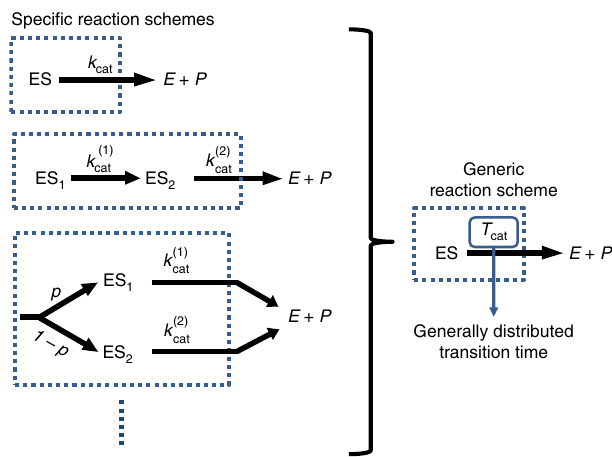
product formation events. Interpreting the kinetic schemes in Fig.